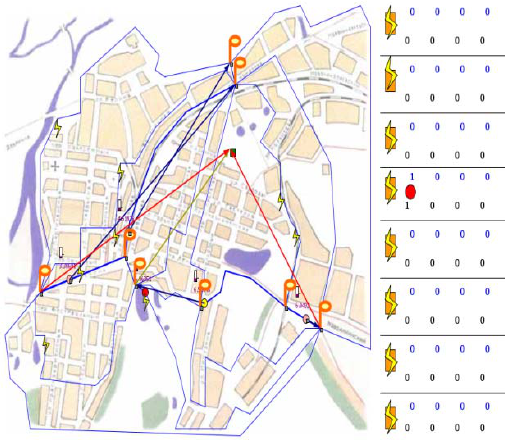
Figure 15. “The simulation of electric-taxi DAR operation system”.